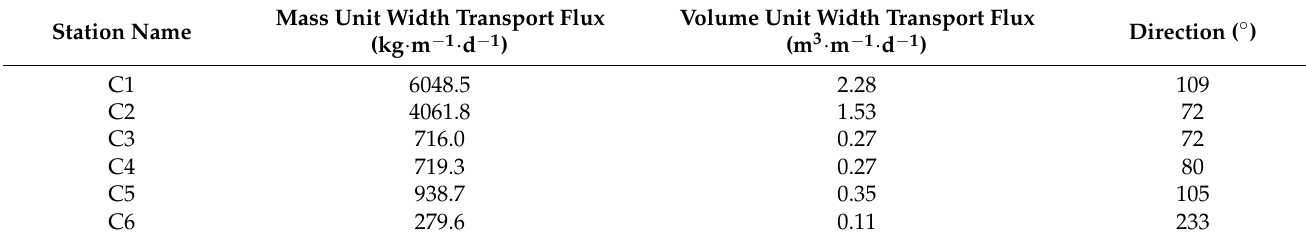
Table 2. The unit width bedload transport flux at the observation